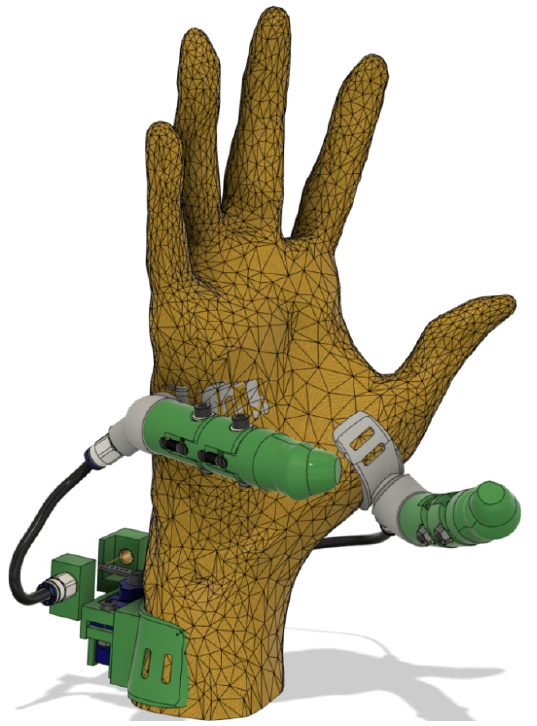
Figure 5. Third thumb at two different positions and motor holder.